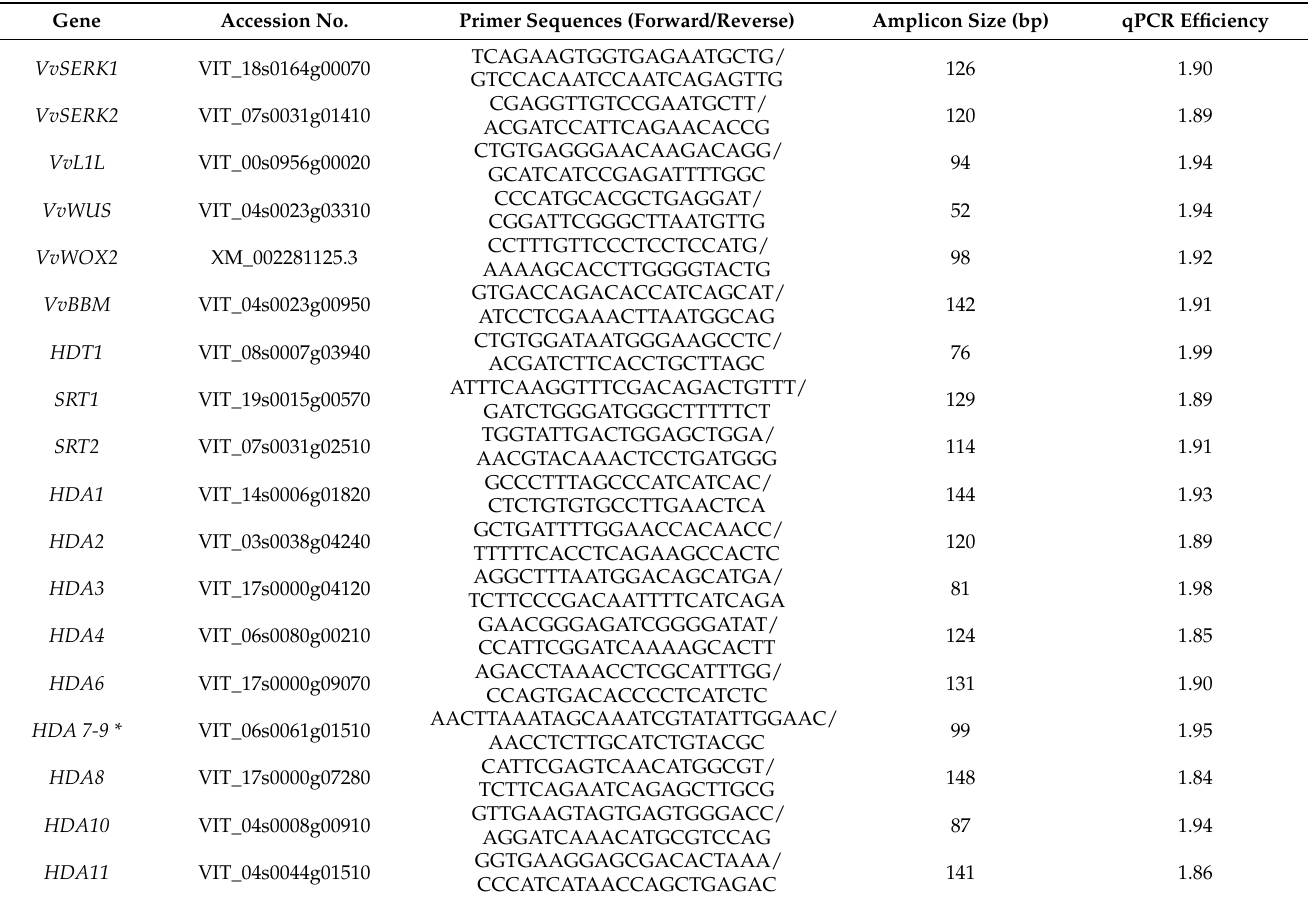
Table 2. Nucleotide sequence, amplicon size and qPCR efficiency of the oligonucleotide primers used in this study. We designed all primers except the qPCR primer pair for the VvWUS gene [20]. Gene Accession No. Primer Sequences